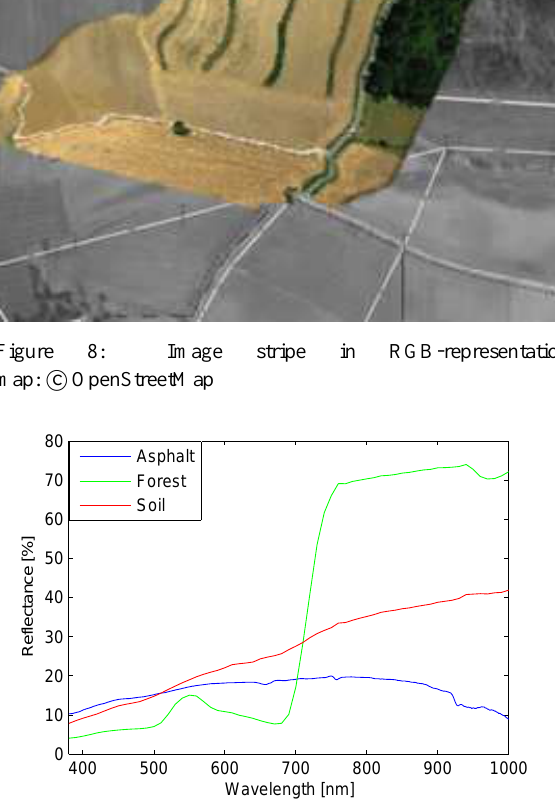
Figure 9: Reflectance spectra for asphalt, forest and soil used for the determination of spectral characteristics of winter wheat and compared with ground based measurements during the vegetation period